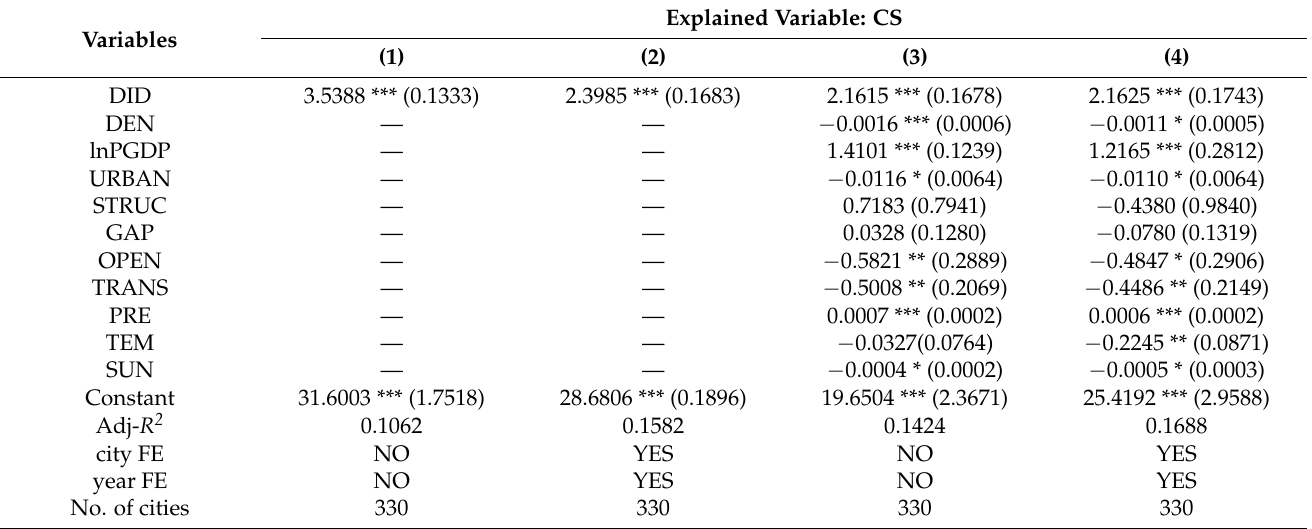
Table 2. Results of baseline